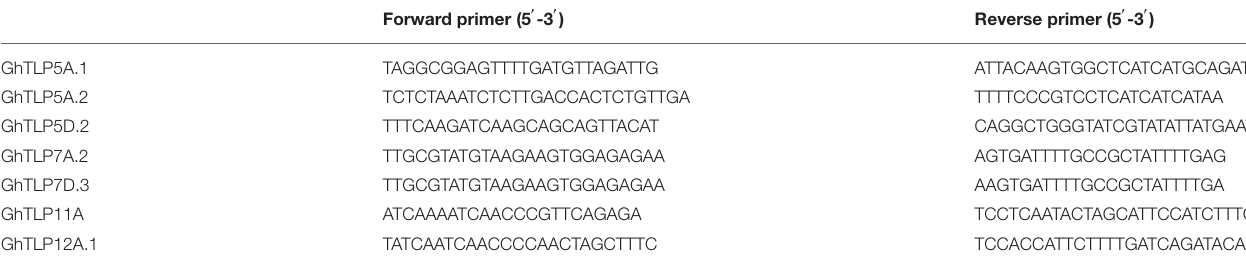
TABLE 3 | A list of primers used for validation in qRT-PCR.